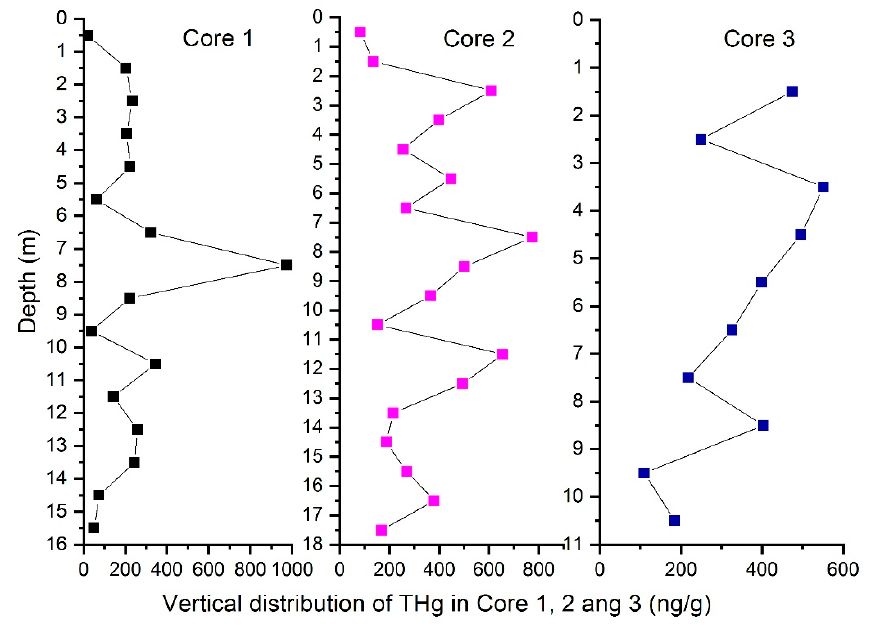
Figure 2. Vertical distribution of total mercury in solid samples in core 1, 2 and 3 (ng/g).